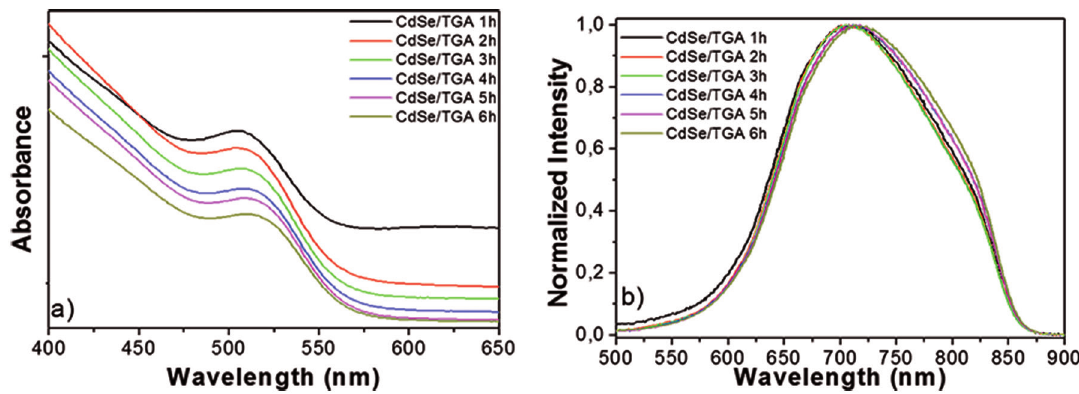
Figure 4: UV-visible absorption a) and fluorescence b) spectra of CdSe/TGA QDs at different reaction times.